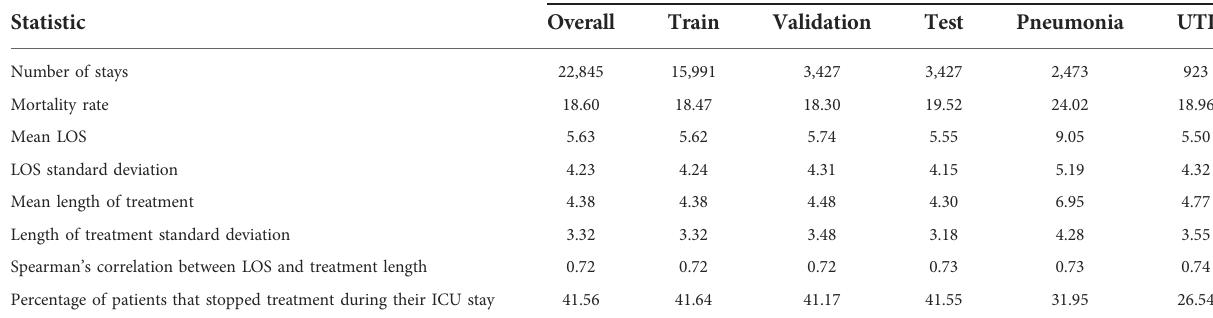
TABLE 1 Datasets statistics.